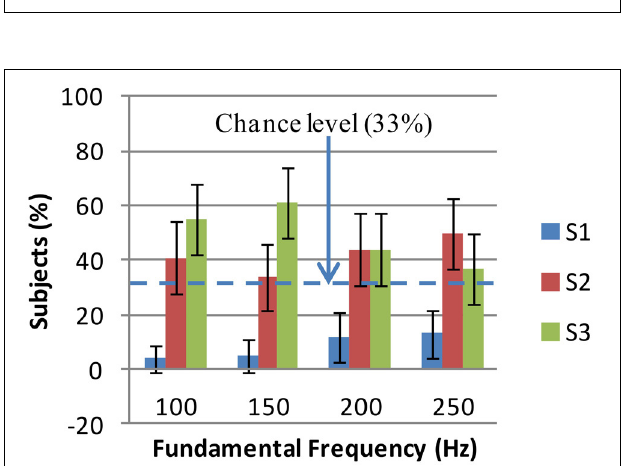
FIGURE 3 | Colored shape selections for fundamental frequency: the percentages of subjects who have selected shapes S1 (jagged), S2 (mixed), and S3 (rounded) for each fundamental frequency are shown. The error bars show Bonferroni adjusted 99.59% confidence intervals (obtained by Z -test). S1 is the least selected shape at all frequencies ( < 13%). There is no significant difference between S3 and S2 percentages except at 150 Hz where S3 is the mostly selected shape (66%). At other frequencies, S2 and S3 are almost equally selected (see text for details). S1, S2, and S3 are the shapes shown in Figure 2 .